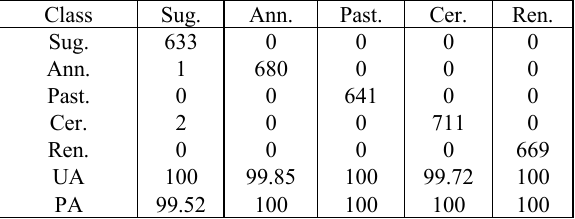
Table 4. Confusion matrix and user’s (UA) and producer’s accuracy (PA) for each class obtained with the Random Forest classification applied to the Harmonized Landsat 8 Sentinel-2 multispectral dataset. Sug. = sugarcane; Ann. = annual crops; Past. = pastures; Cer. = Cerrado native vegetation; Ren. = renovated sugarcane